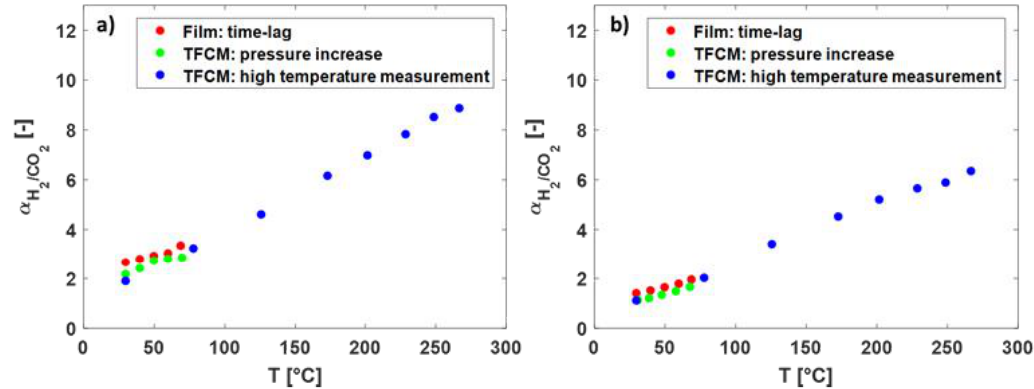
Figure 7. ( a ) The selectivity of H 2 / CO 2 (-) over the temperature ( ◦ C) in Matrimid ® and ( b ) in 6FDA-6FpDA for di ff erent membranes and measurement methods.